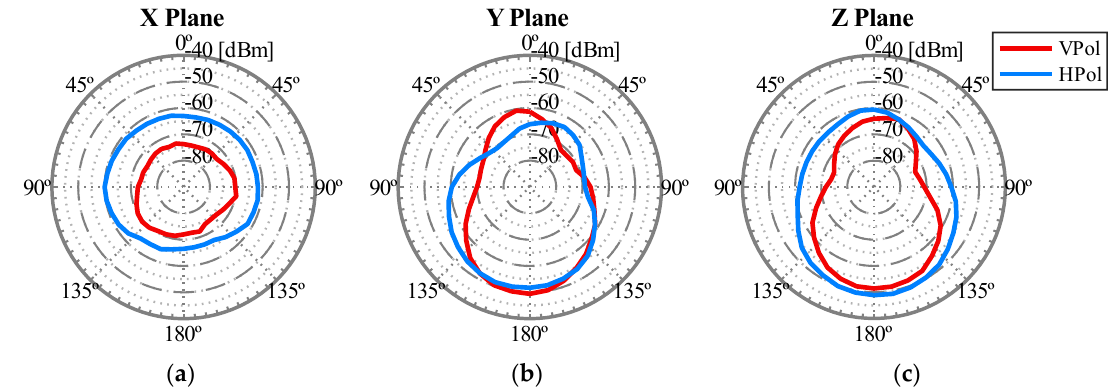
Figure 14. Radiation pattern of the isolated WiTi using the antennas configuration shown in Figure 13 in the U2G link working in 2.4 GHz: ( a ) X Plane, ( b ) Y Plane, and ( c ) Z Plane.